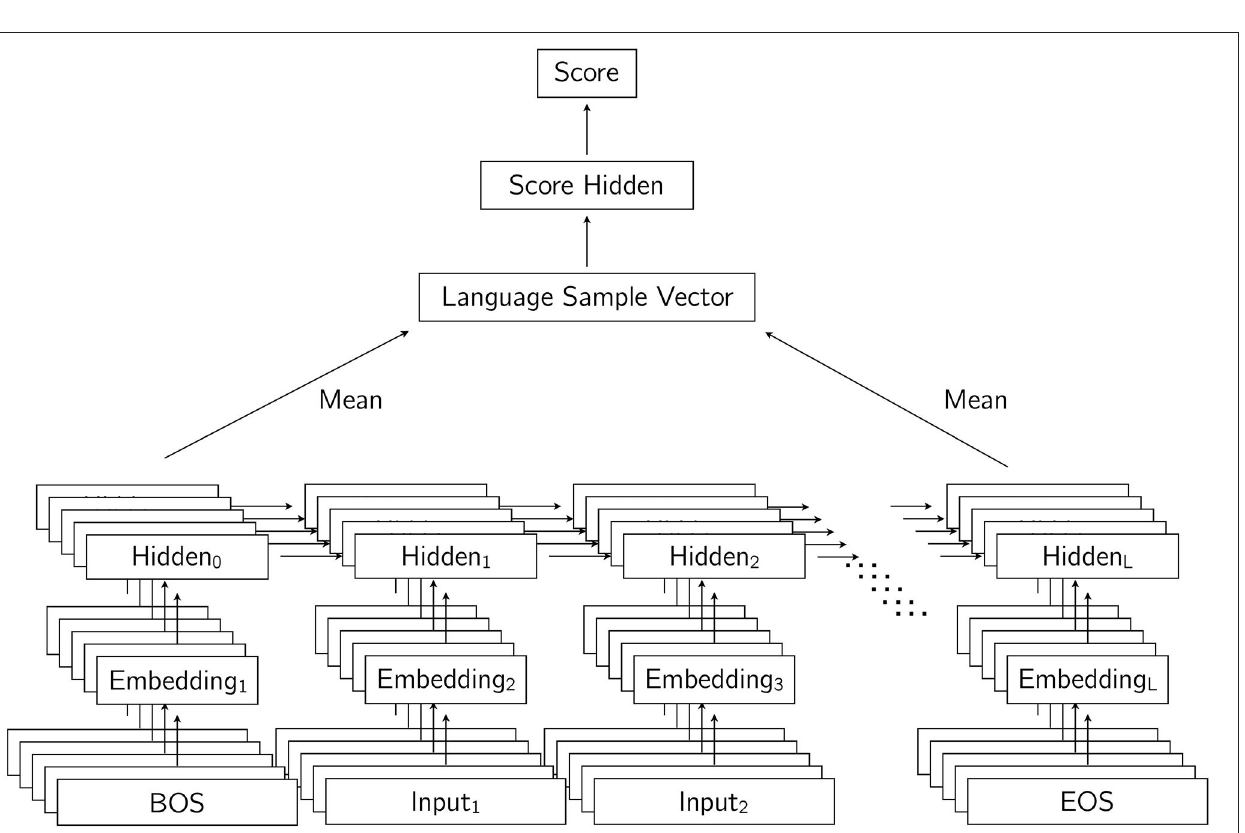
FIGURE 4 | Our model for encoding and scoring language samples composed of utterances. Each utterance is encoded by a Bidirectional LSTM network. Utterance representations consisting of the concatenations of the first and last tokens are averaged into a vector that represents the entire language sample. From this language sample vector, a score is computed for the entire language